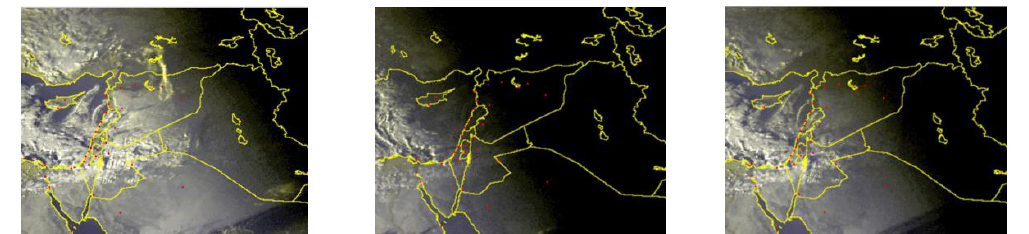
Fig. 4: Goes visible satellite images taken over Iraq in 18/12/2016 at 17:15, 17:30 and 17:45 pm.